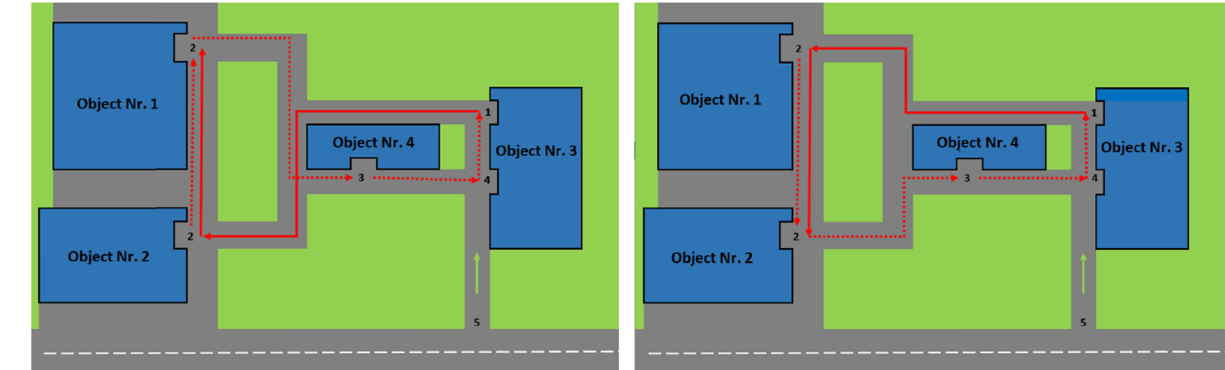
Figure 7: Supply of object variants A and